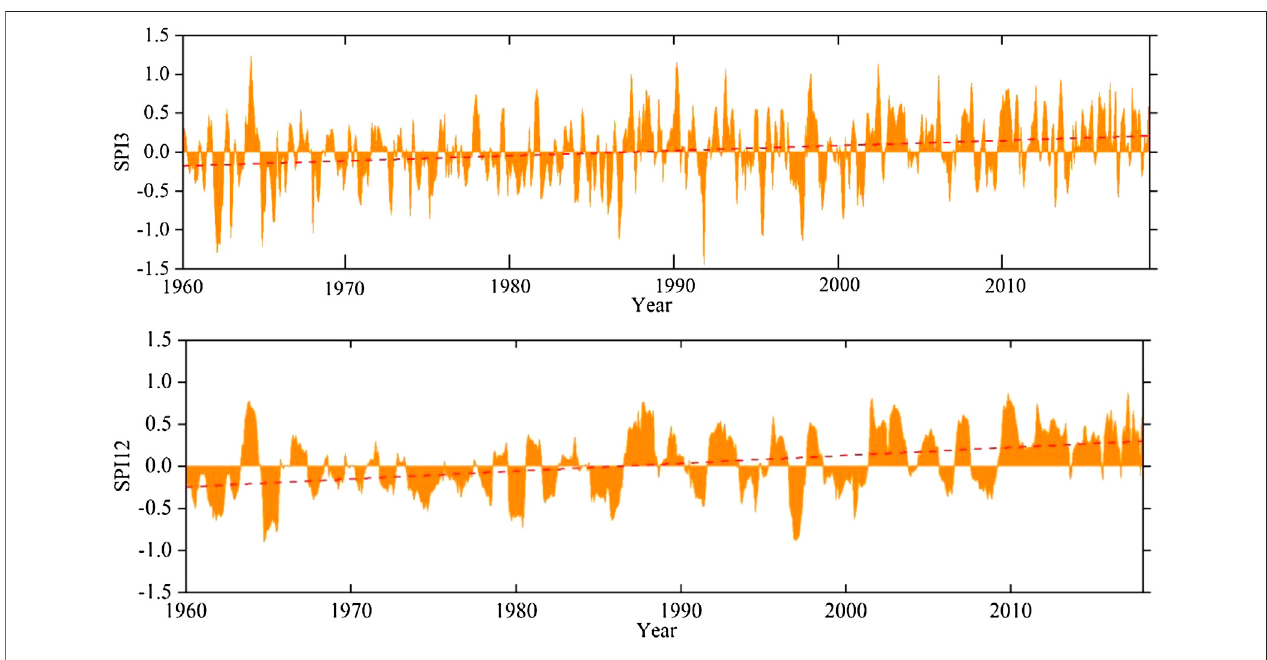
FIGURE 3 | Variation of SPI series from 1960 to 2018 in